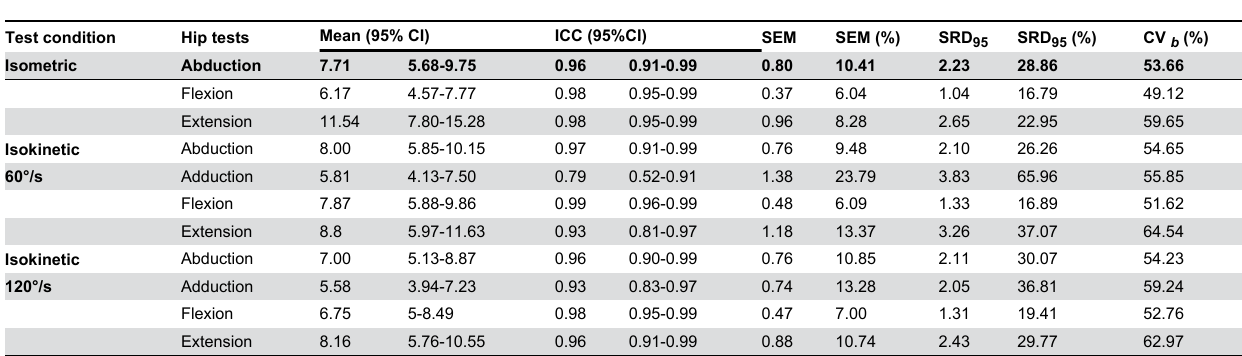
Table 2. Reliability, variability and clinical important change of normalized hip torque measures using Biodex dynamometer.